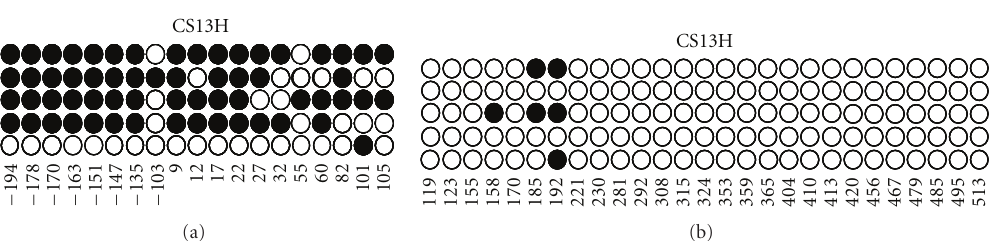
Figure 5: The maspin promoter and 14-3-3 σ gene are hypomethylated in mRNA expressing chondrosarcoma cell lines. Bubble charts of the maspin promoter (a) and 14-3-3 σ gene (b) for the five chondrosarcoma cell lines analyzed. Each of the five rows represents a sequenced amplicon while each column represents the nucleotide position of the CpG measured relative to the transcription start site. Darkened circles represent methylated cytosines, and clear circles represent unmethylated cytosines. Nucleotide positions relative to start site were based on UCSC genome browser build